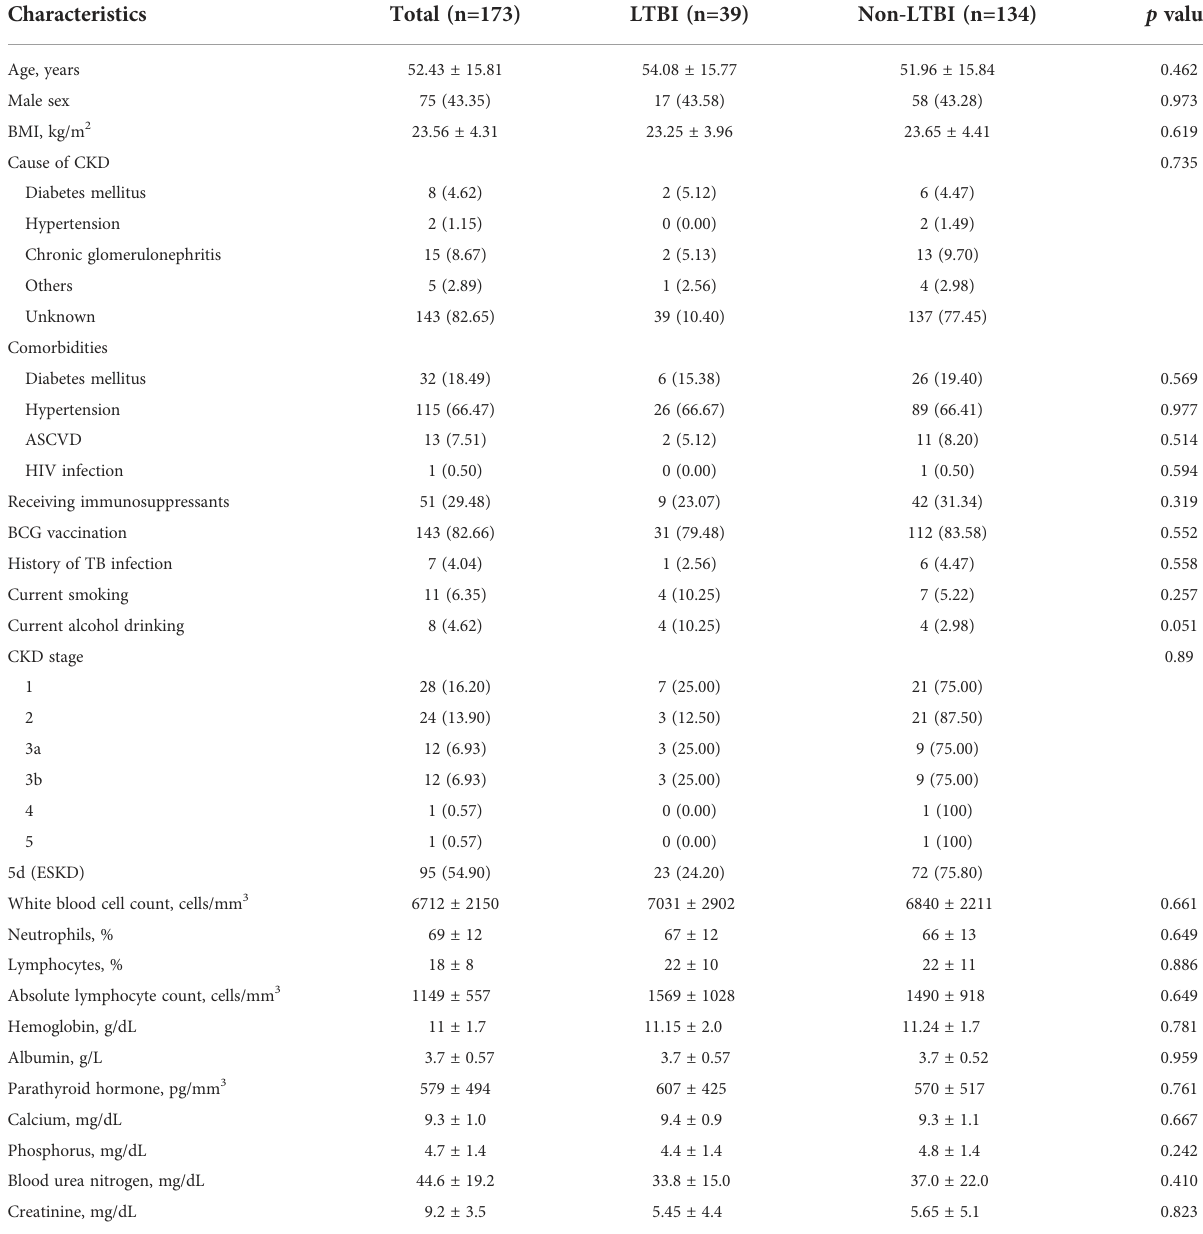
TABLE 1 Characteristics of patients with